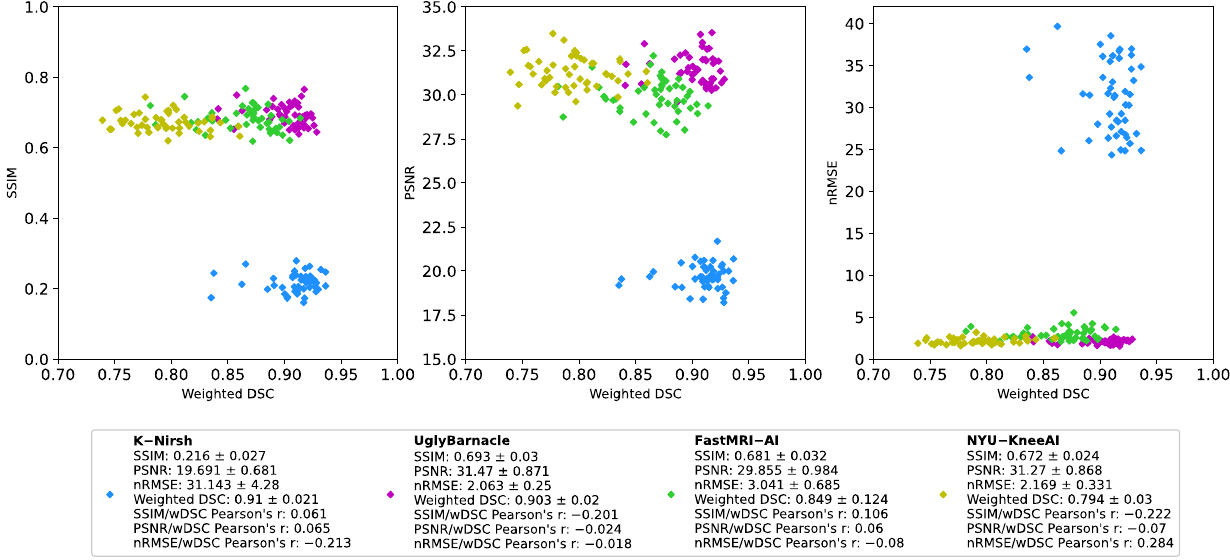
Figure 8. Reconstruction metrics (nRMSE, PSNR, SSIM) plotted against weighted DSC for each of the top four submissions, with each point denoting a subject in the test set (n = 50). Pearson’s correlation coefficient was calculated for each pair and is displayed on the chart, indicating that at absolute best, there was a weak correlation between segmentation and reconstruction metrics, and that in most cases, there was no or even negative correlation.